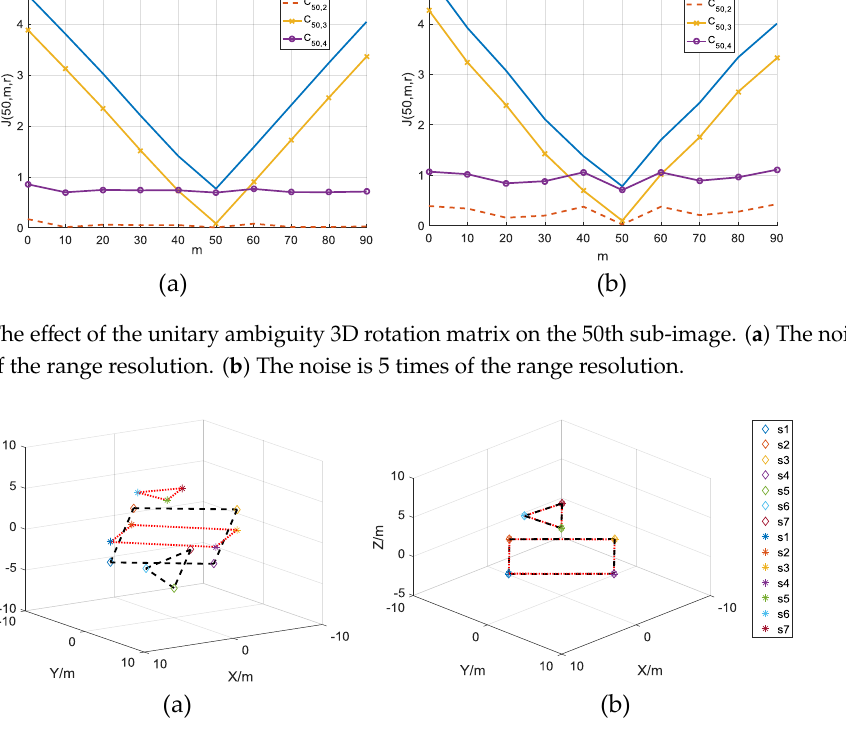
Figure 8. The attitudes from the 3D reconstruction result with the standard derivation of the noise is set to be half of the range resolution. (a) The traditional 3D reconstruction. (b) The proposed 3D reconstruction.